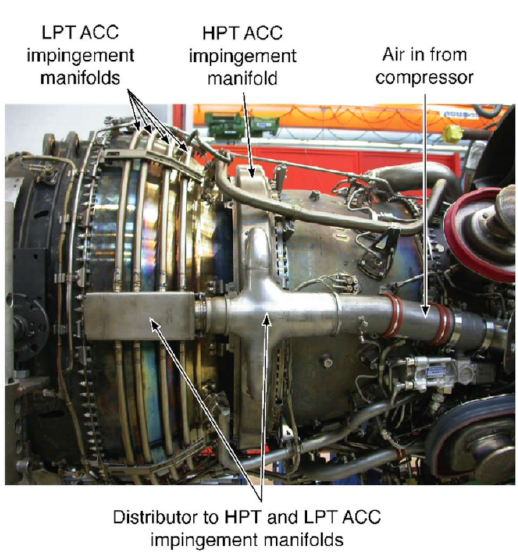
Figure 1. An MTU aero-engine ACC single-entry impingement feed system, adapted from [11].